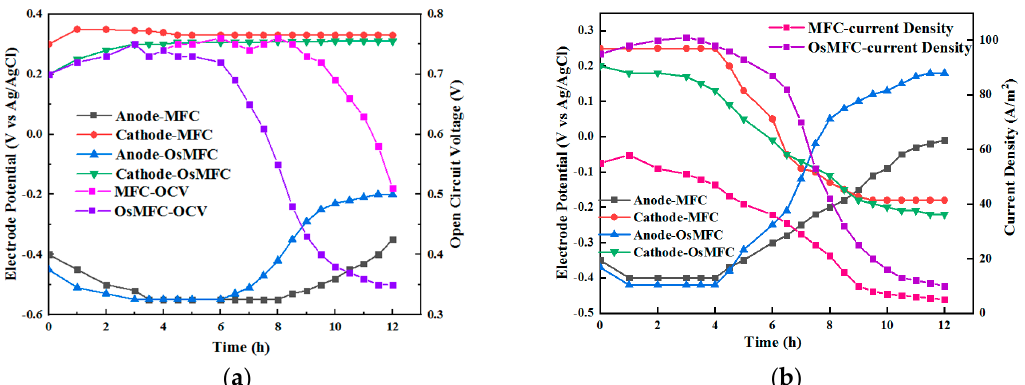
Figure 4. ( a ) Comparison of current density and cathode and anode potentials under open-circuit conditions; ( b ) comparison of current density and cathode and anode potentials under closed-circuit conditions.